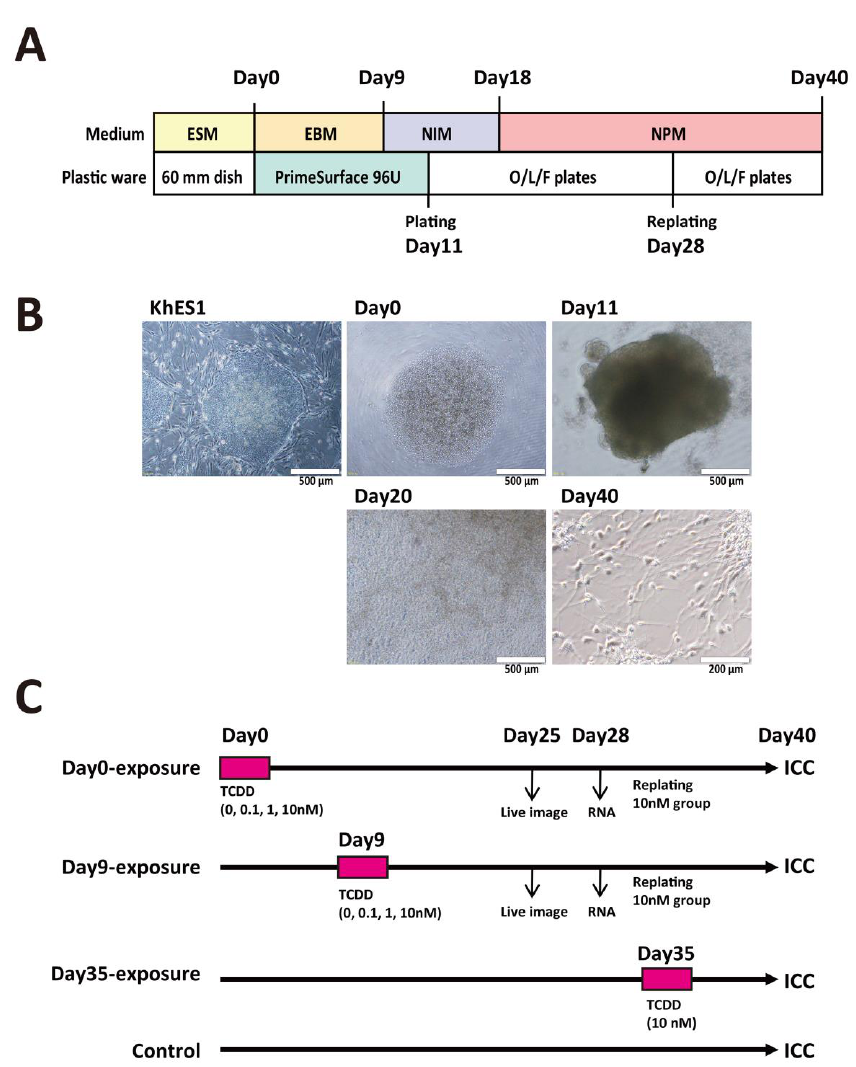
Figure 1. Schematic diagram of the bulk-passage system for neural differentiation using human embryonic stem cells (ESCs) and the experimental schedule for 2,3,7,8-tetrachlorodibenzo- p -dioxin (TCDD) exposures. ( A ) Culture schedule, media, and plastic ware in the protocol. hESCs were sub-cultured on mouse embryonic fibroblasts (MEFs) as feeder cells in embryonic stem cell medium (ESM). Embryoid bodies (EBs) were formed in PrimeSurface 96U plates with embryoid body medium (EBM) containing the ROCK inhibitor Y-27632 as described in Materials and Methods. The growing EBs were cultured for 2 additional days in neuronal induction medium (NIM) to promote neural differentiation. Then, EBs were replated onto ornithine/laminin/fibronectin (O/L/F)-coated plates. On Day18, the medium was changed with neural proliferation medium (NPM). On Day28, all cells in one well were detached with Accutase and replated onto new O/L/F-coated plates. ( B ) Typical features of cells and cell masses at various stages. Upper left, KhES1 colony. Upper middle, hESCs immediately after plating onto PrimeSurface 96U. Upper right, EB on Day11. Lower middle, cell masses on Day20. Lower right, neuronal cells on Day40. ( C ) Experimental schedule for examining the effects of TCDD exposure of cells at di ff erent stages. On Day0 immediately after plating single KhES1 cells on PrimeSurface 96U, TCDD (0, 0.1, 1, 10 nM) was added to EBM and the cells were incubated for 24 h (Day0-exposure group). On Day9 at the EB stage, TCDD (0, 0.1, 1, 10 nM) was added and the EBs were incubated for 24 h (Day9-exposure group). On Day35, mature neuronal cells were exposed to TCDD (10 nM) for 24 h (Day35-exposure group). Total RNAs were collected to measure specific mRNA on Day28. Immunocytochemistry (ICC) was performed on